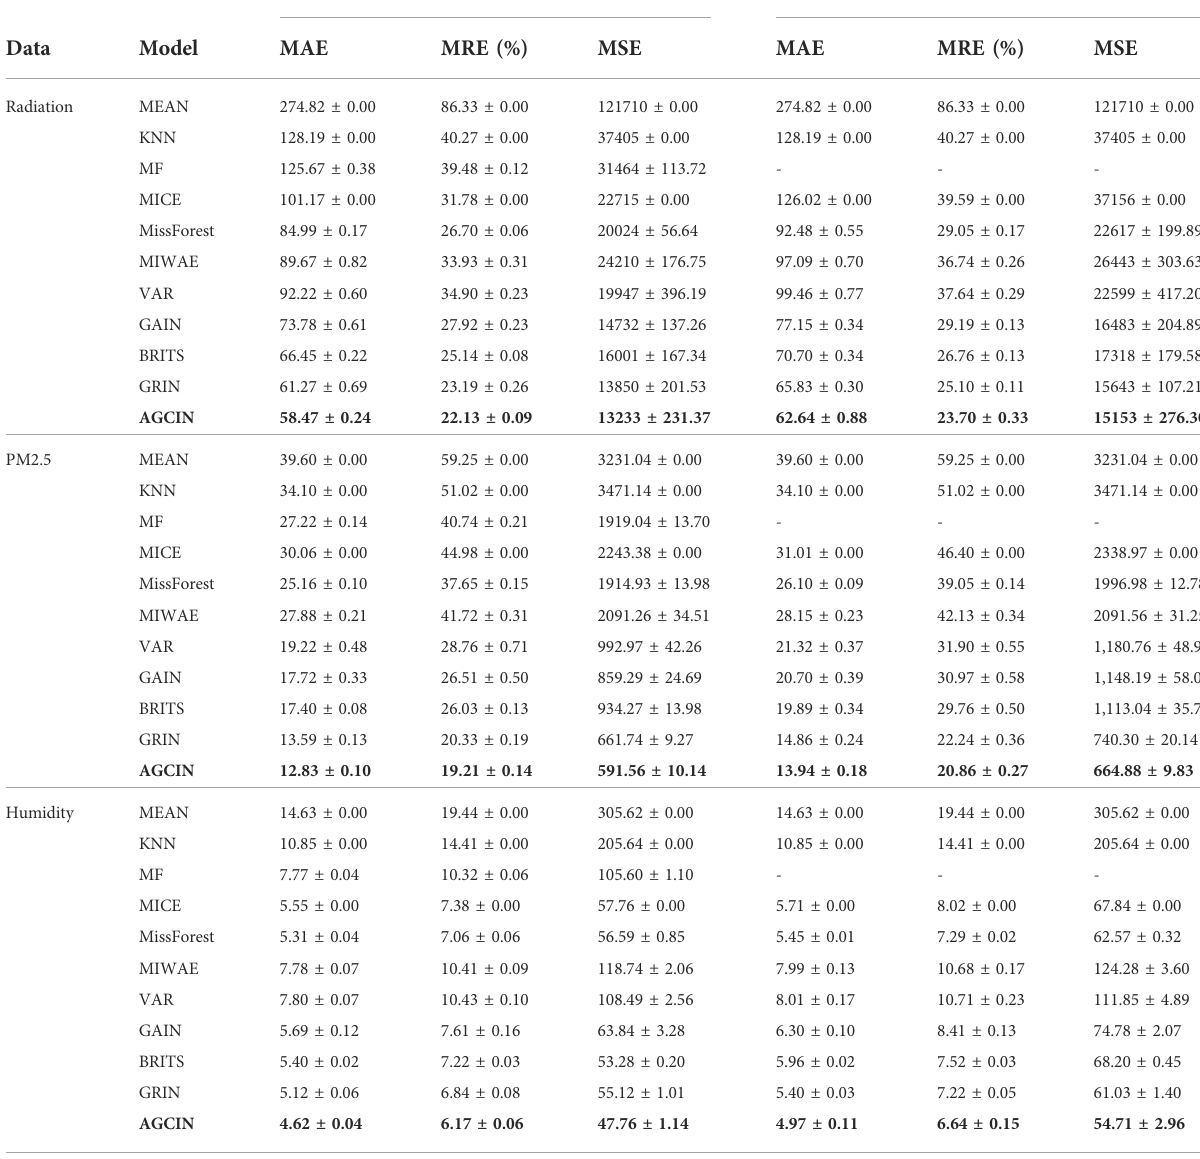
TABLE 2 Imputation performance comparison of the proposed AGCIN and baseline methods.